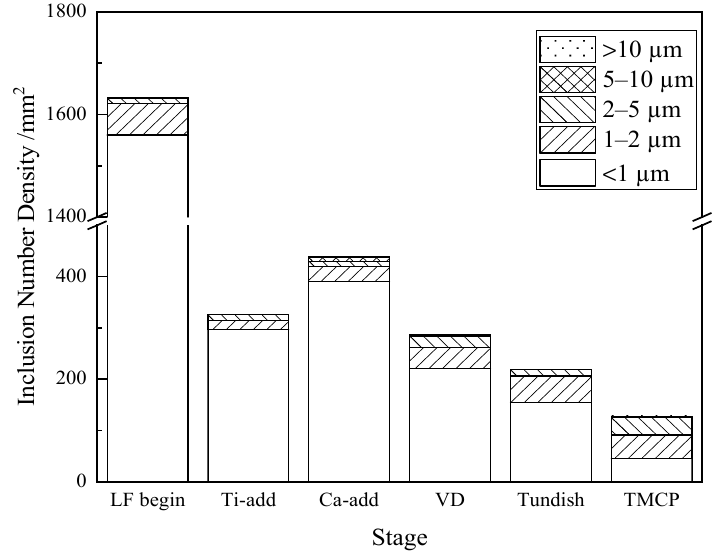
Figure 2. The number density of inclusions at different stages.